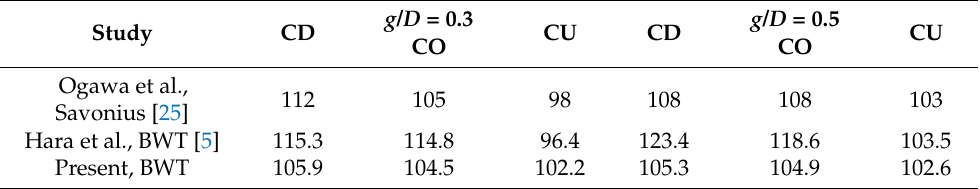
Table 2. Comparison of normalized power P norm = P ave / P SI . BWT means Butterfly Wind Turbine (see Section